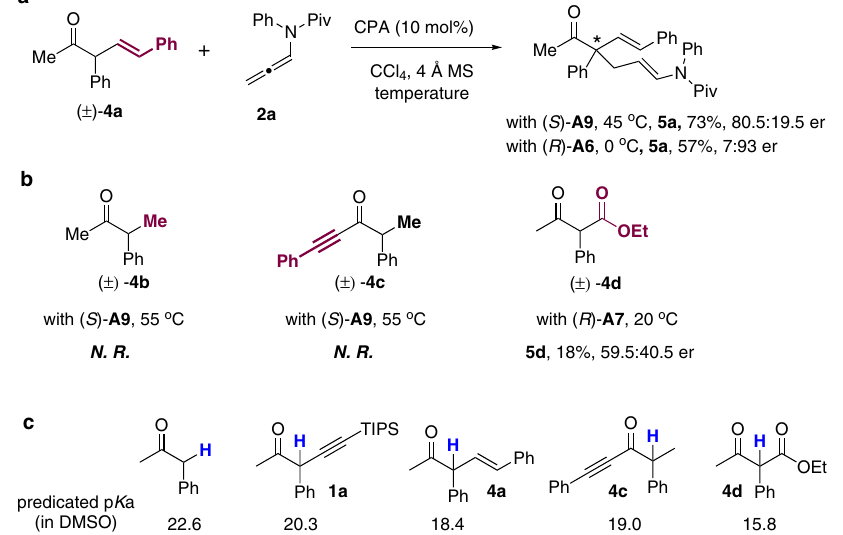
Fig. 4 Control experiments. a Reaction of α -alkenyl ketone substrate. b Reactions of α -alkyl ketone 4b , α -branched ynone 4c and β -ketoester 4d in this reaction. c Predicted p K a values of ketone substrates. with 7:93 er. These results indicated that this reaction is not only